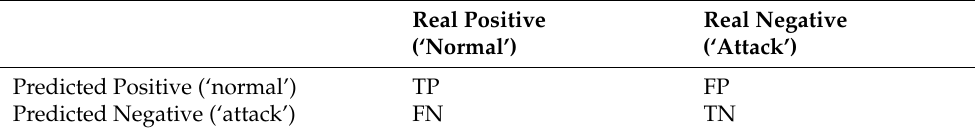
Table 3. The Confusion Matrix.